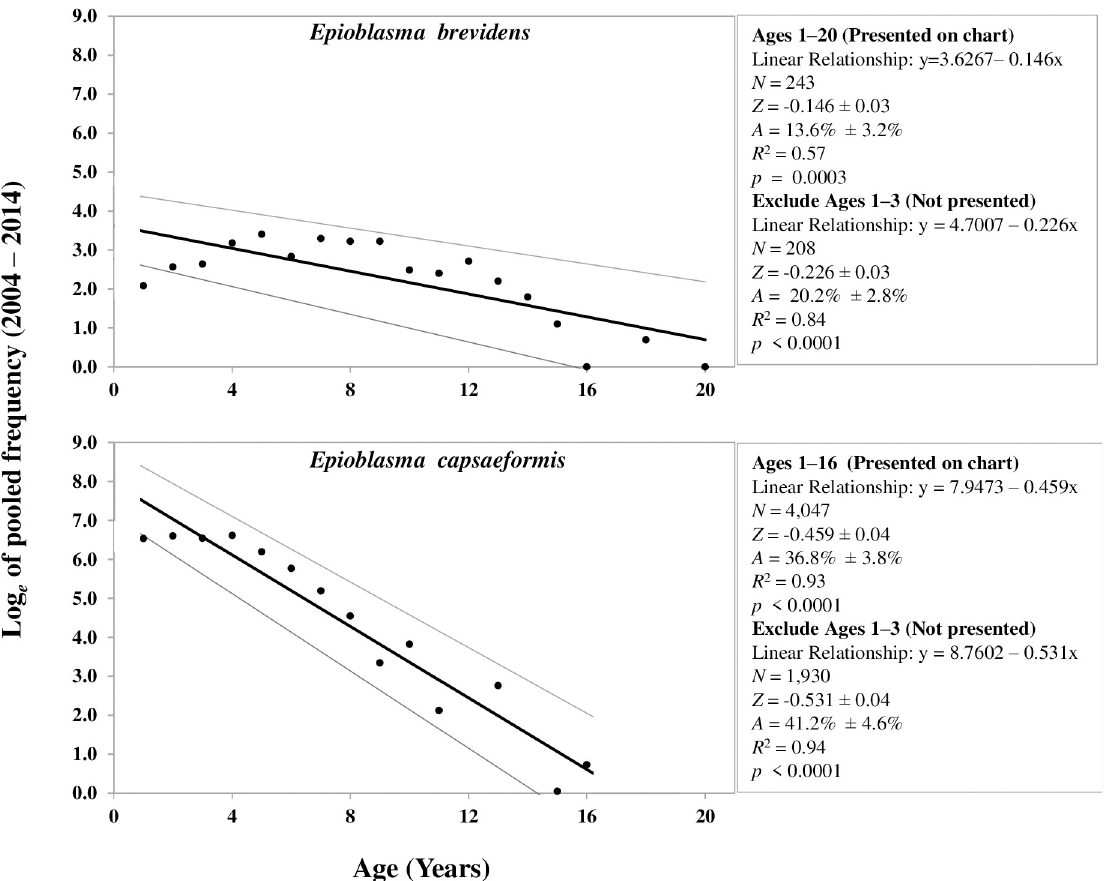
Fig 8. Mortality rates of Epioblasma brevidens and E . capsaeformis estimated from catch-curve linear regression analyses based on age class frequencies of all individuals sampled at Swan Island, Frost Ford, and Wallen Bend in the Clinch River, Hancock County, TN, from 2004–2014. As shown, Ages 1–3 were included in age-class frequency plots, where thin grey lines are 95% confidence intervals of the mean linear regression line (Bolded). For both species, estimated mortality rates are reported in the respective boxes to the right of the age- class frequency plots, where N = sample size, Z = instantaneous mortality rate, and A = annual mortality; rates were estimated with and without Ages 1–3. Age 0 individuals were not used in the analyses.